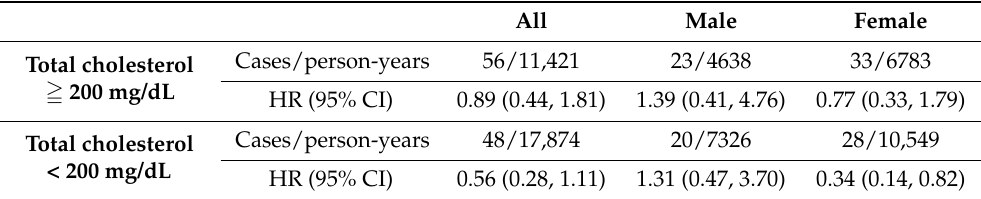
All Male Female